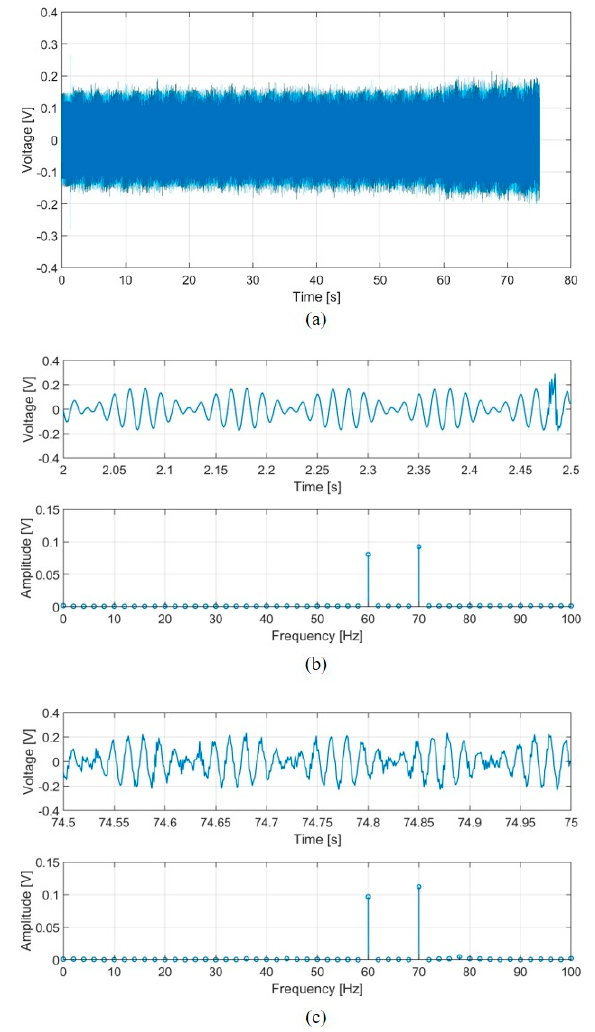
Figure 11. Experimental results: ( a ) voltage signal measured at R ext , ( b ) FFT analysis in the superconducting state, and ( c ) FFT analysis in the normal state.